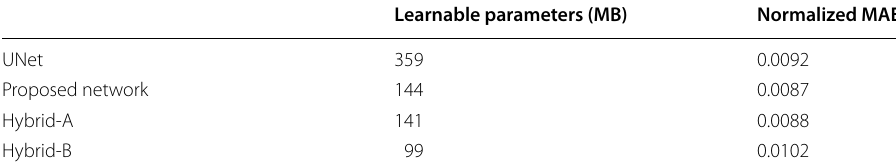
Table 1 The performance comparison of networks with different structures